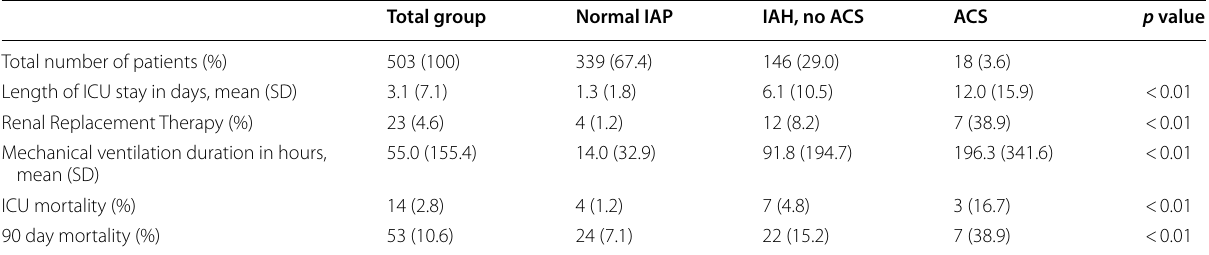
Table 7 Morbidity and mortality of patients with IAH and ACS compared to patients with normal IAP